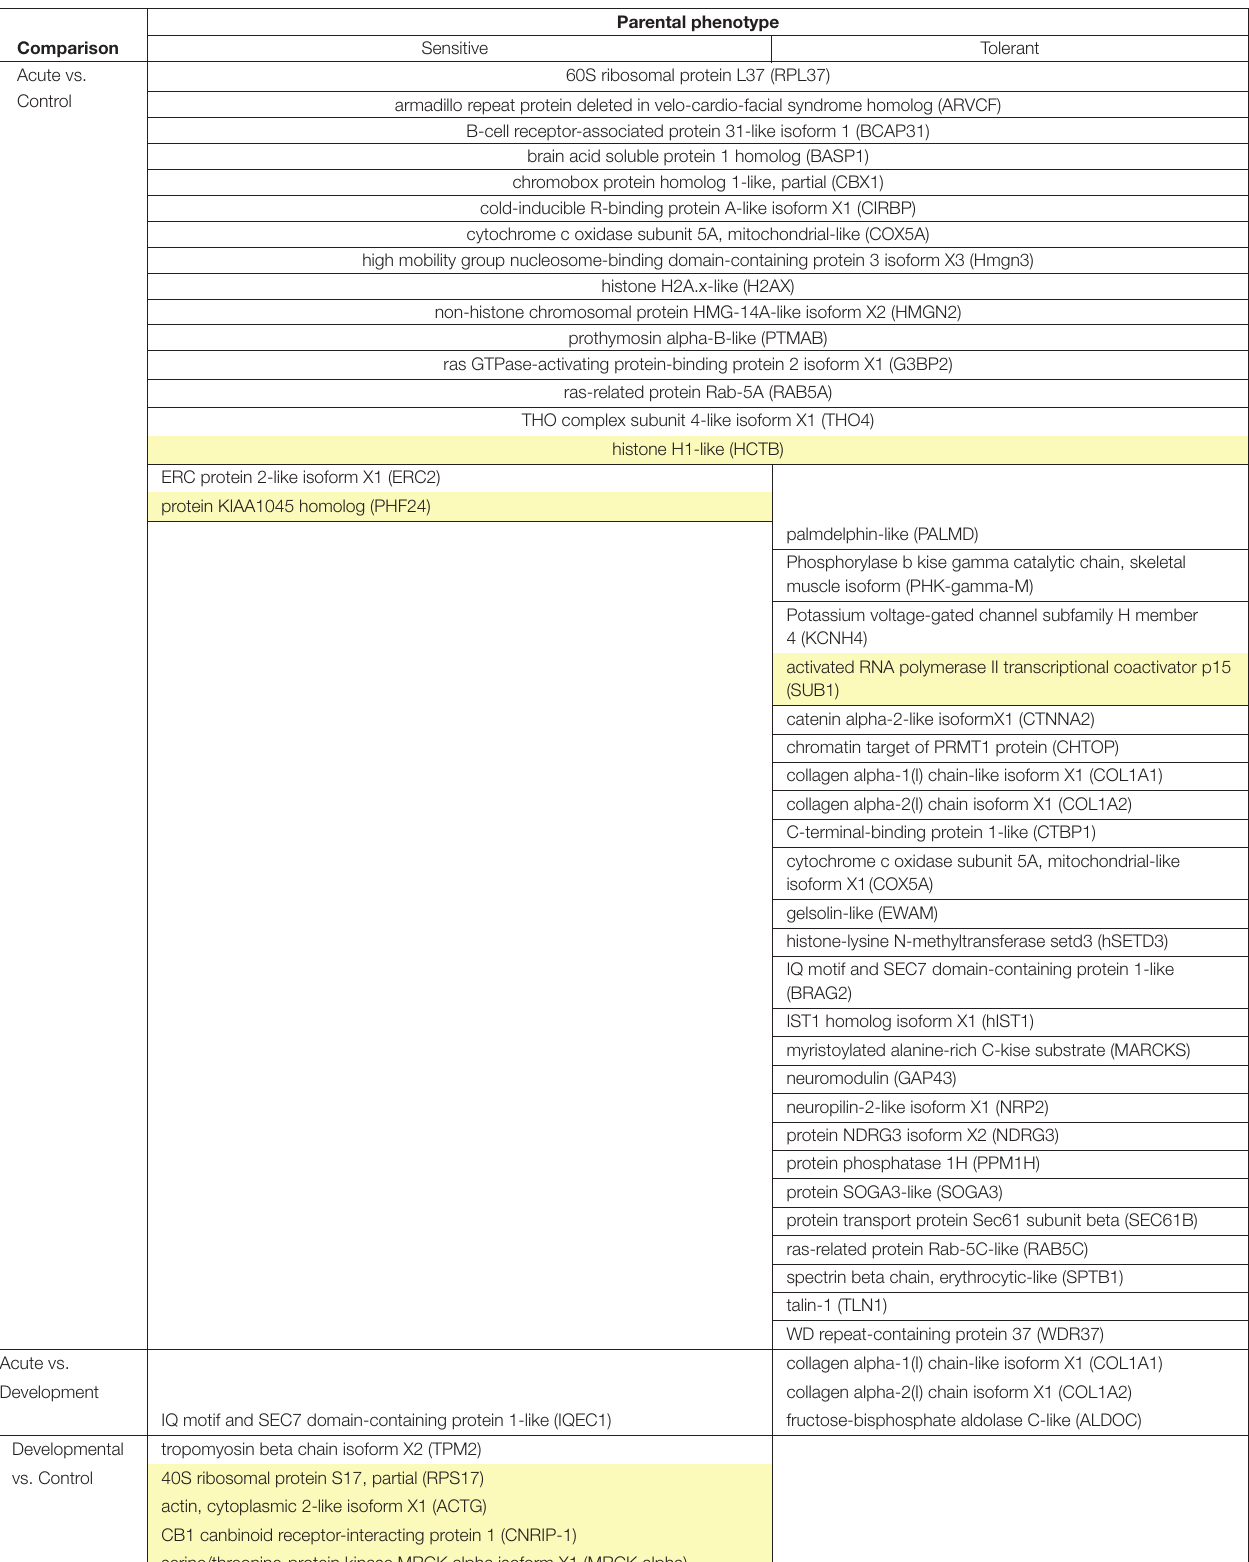
TABLE 1 | Differentially accumulated proteins (DAPs) in the brain of 5-week-old juvenile A. polyacanthus exposed to four different CO 2 treatments: Acute ( n = 6) vs. Control ( n = 6), Developmental ( n = 6) vs. Control ( n = 6), and Inter-generational ( n = 6) vs. Control ( n = 6) for each parental phenotype (sensitive and